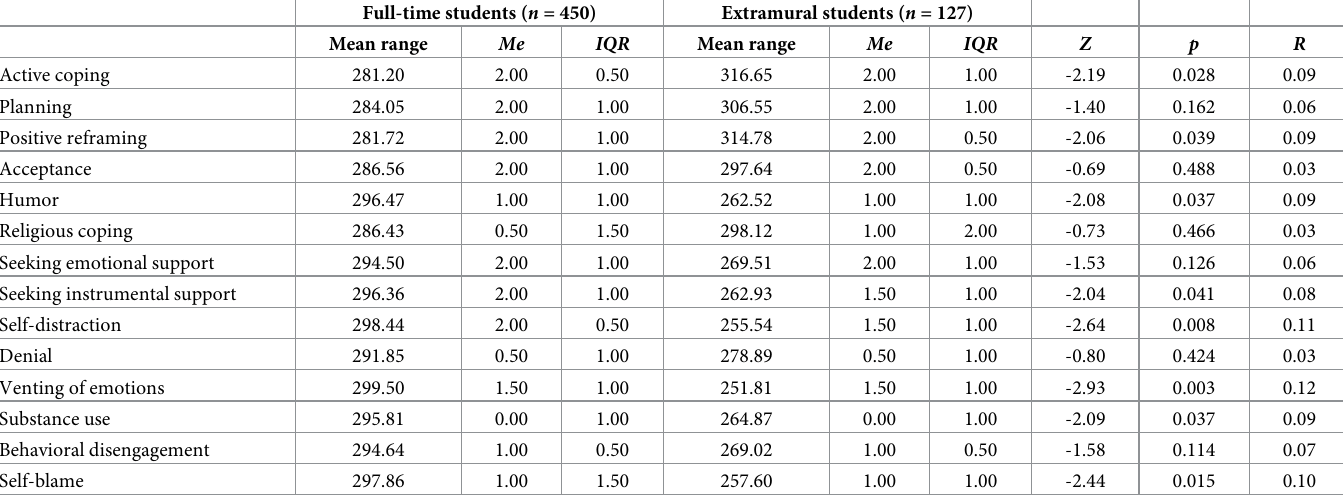
Table 9. Comparison of coping strategy use between full-time and extramural